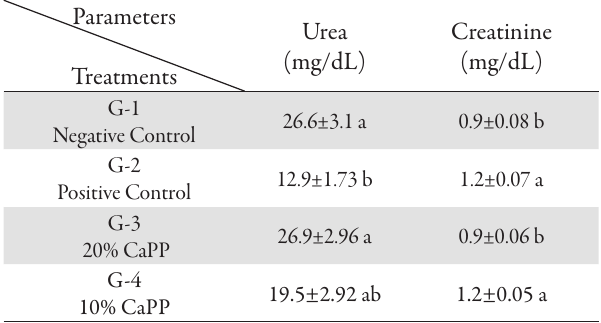
Tab. 6. Plasma urea and creatinine (mg/dL) of the experimental